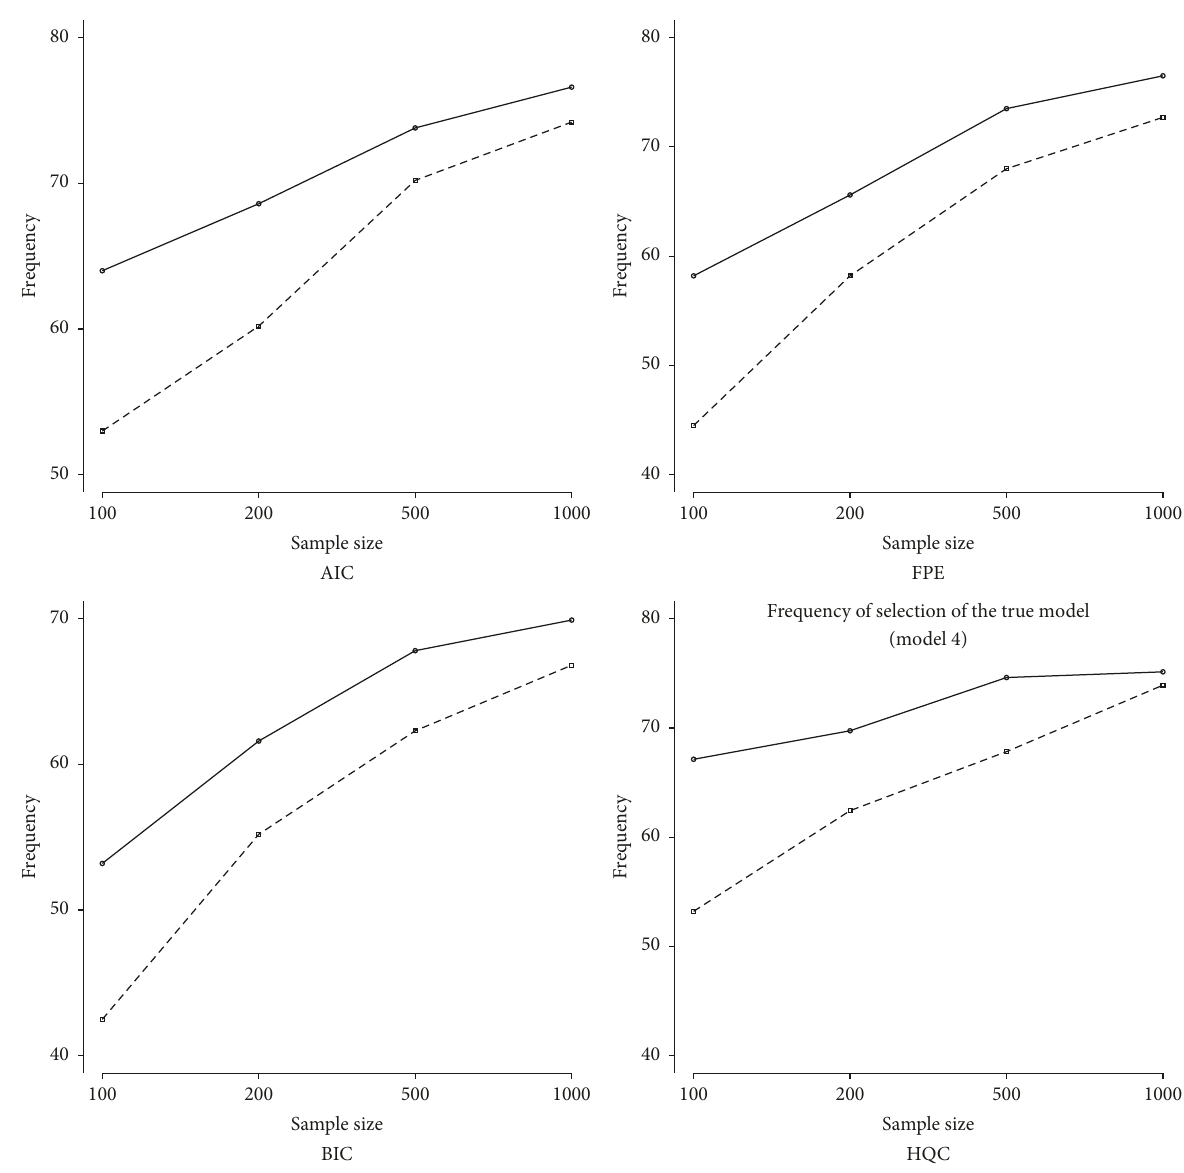
Figure 1: Frequency of selection of the true model, DGP C, Table 4: SC (continuous line) and SC ∗ (dashed line).